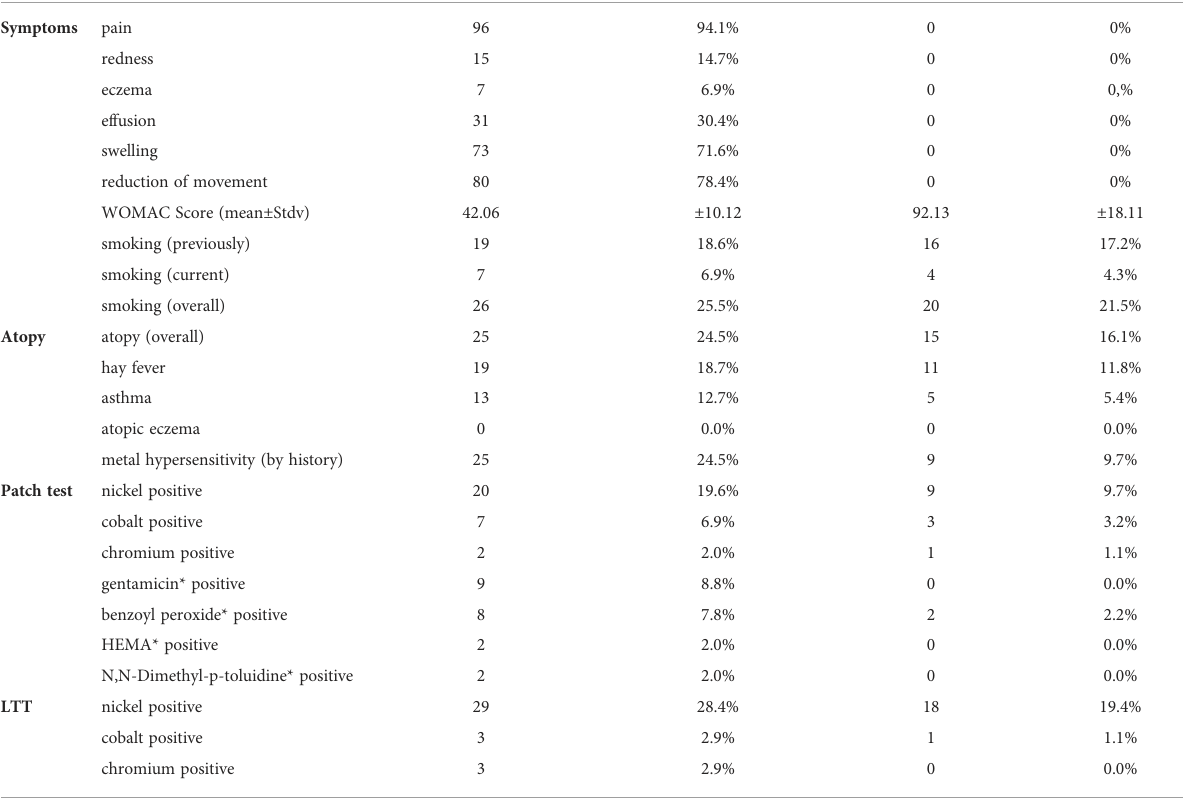
TABLE 3 Results of the questionnaire, patch test and LTT in the patient groups (partly multiple positive reactions in the same patient). Arthroplasty patients with complaints